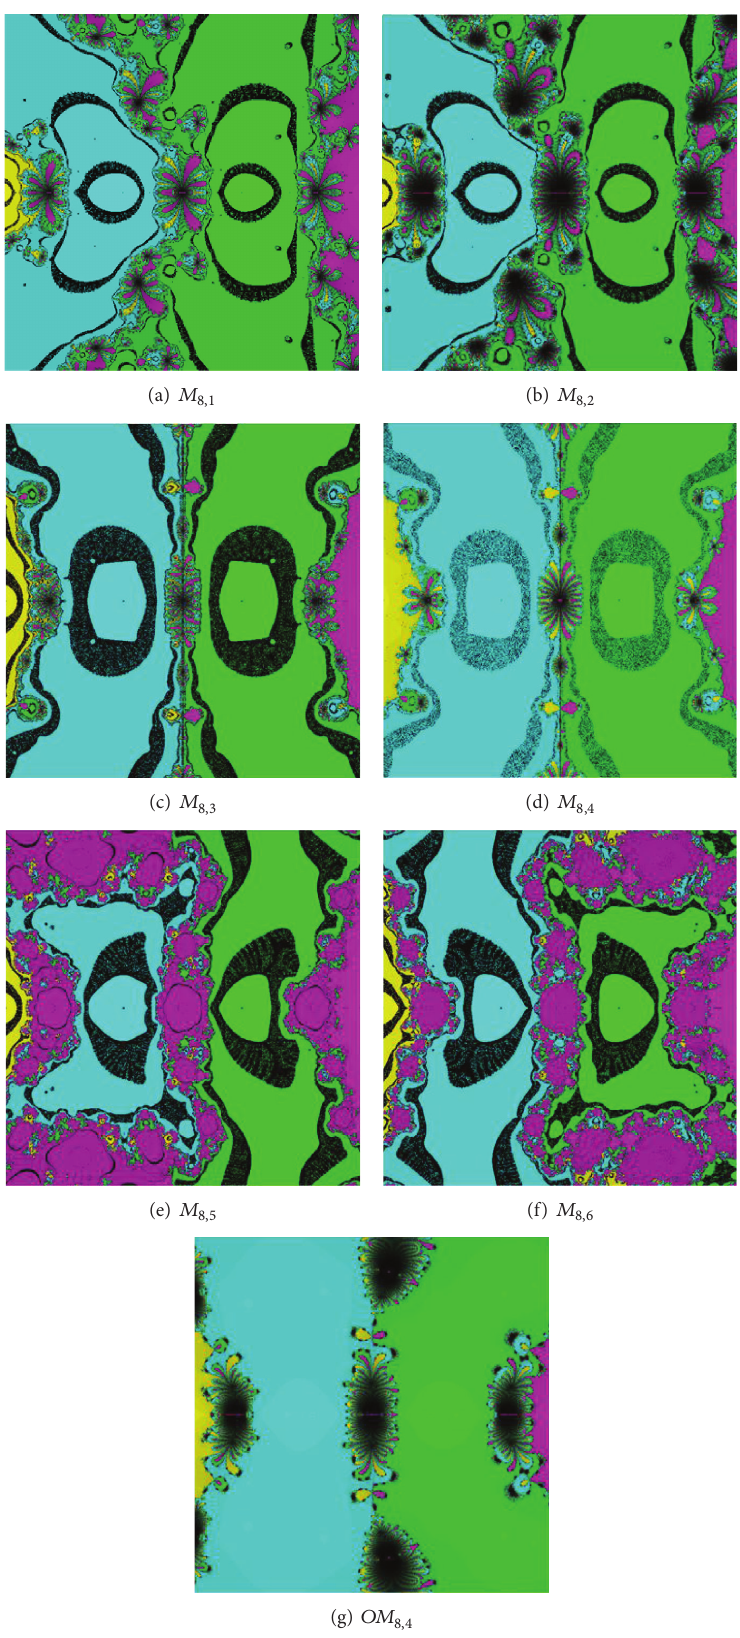
Figure 5: Basins of attraction for polynomial 𝑃 1 (𝑧) = (𝑧 4 − 10𝑧 2 + 9)